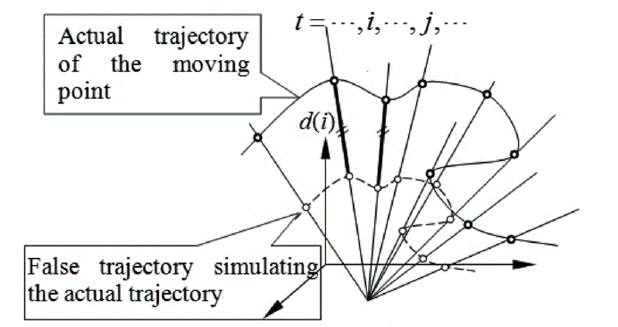
Figure 2. Failure to determine the actual trajectory when lines-of-sight intersect at one